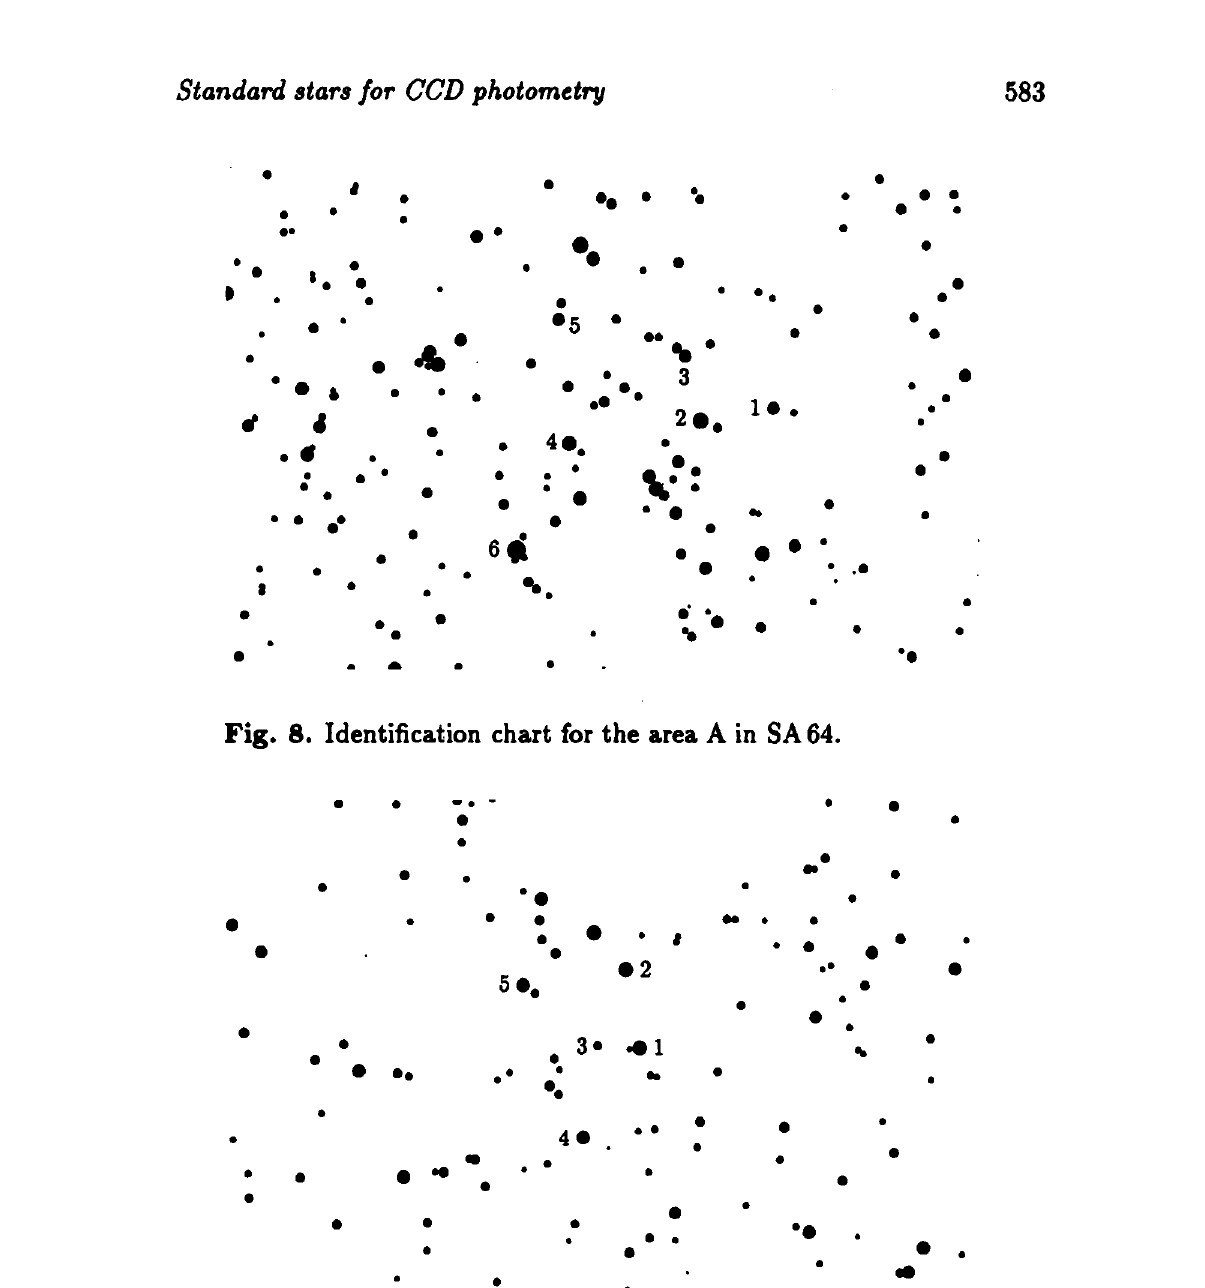
Fig. 9. Identification chart for the area B in SA